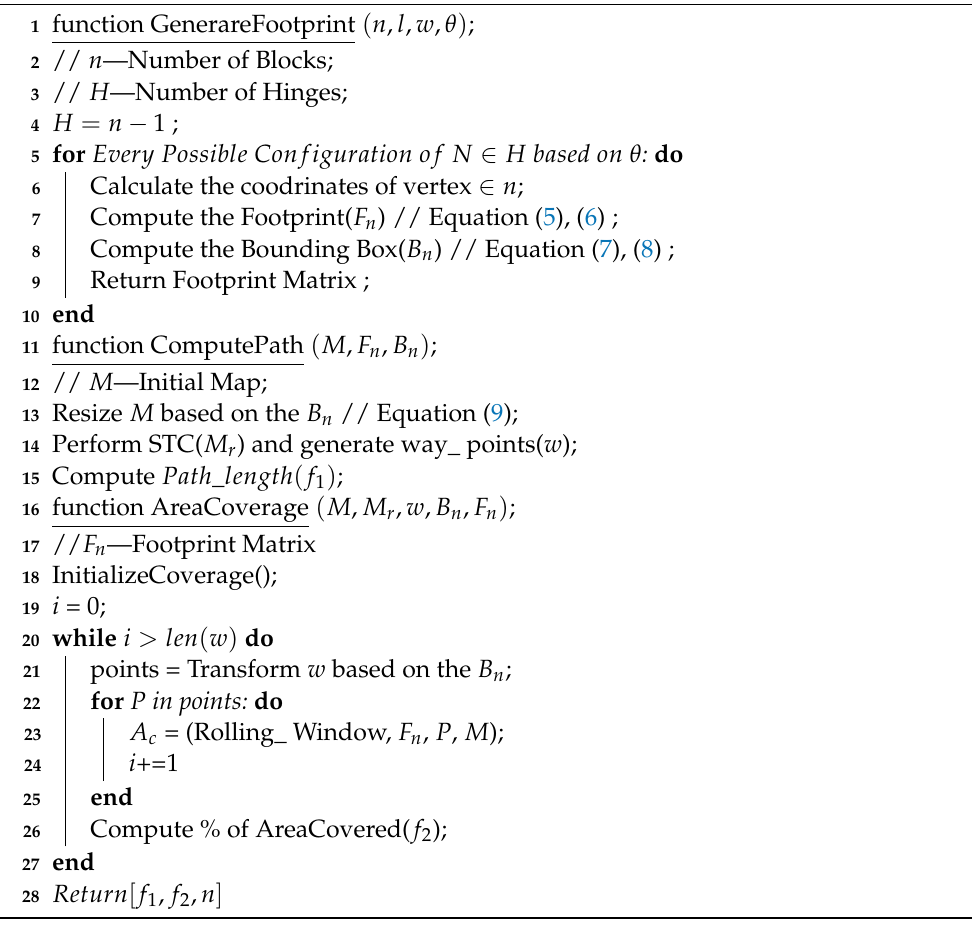
Figure 6. ( a ) Initial Environment, ( b ) Smorphi (cid:48) s footprint configuration with the ( α 12 , α 23 , α 34 ≡ 5,165,5), and ( c ) resized map based on the footprint with the implemented complete coverage planning. Algorithm 2: Footprint-Based Complete Coverage Path planner